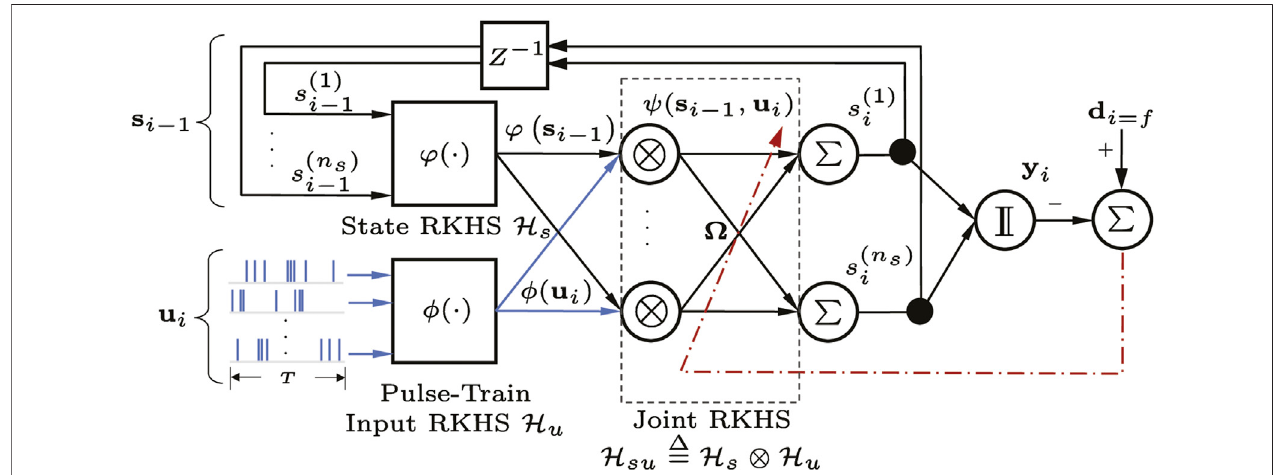
FIGURE 2 | A kernel adaptive autoregressive-moving-average (KAARMA) network operating on multichannel pulse trains.